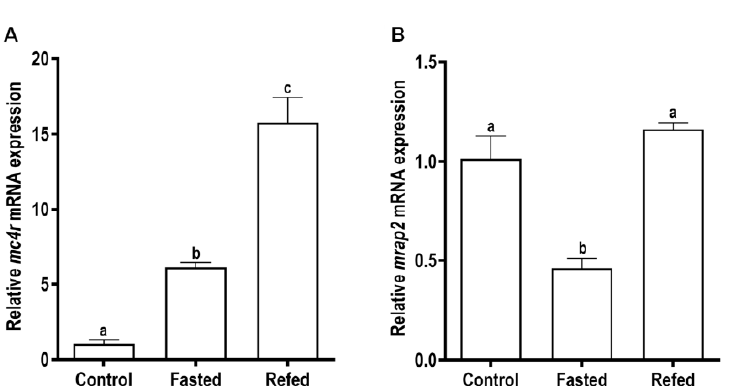
Figure 6. Effects of long-term (2 weeks) fasting and refeeding on expressions of brain mc4r ( A ) and mrap2 ( B ) in snakehead. Data were presented as mean ± SEM ( n = 6). Significant difference ( p < 0.05) between groups was determined using one-way ANOVA. Groups that differ significantly were indicated by different letters above